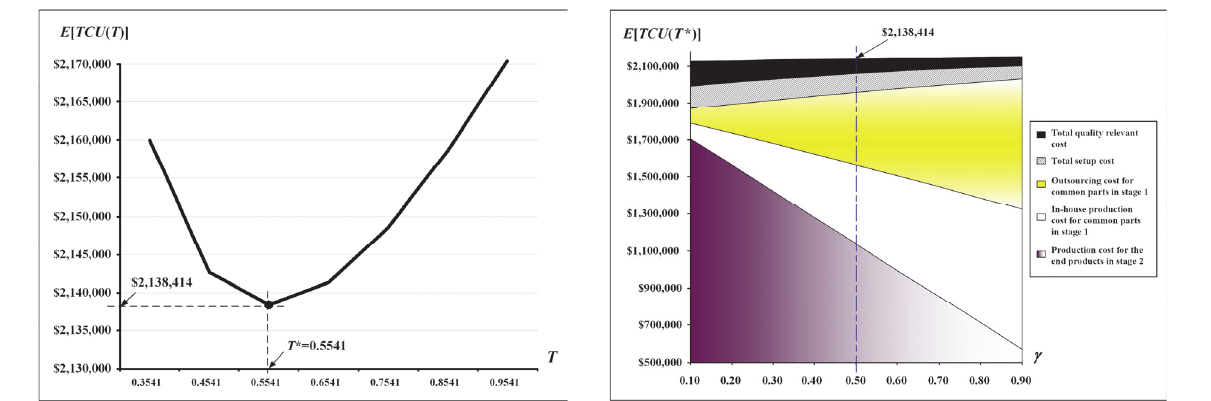
Fig. 5. The behavior of E [ TCU ( T )] regarding T Fig. 6. The behavior of cost contributors to E [ TCU ( T* )] relating to γ